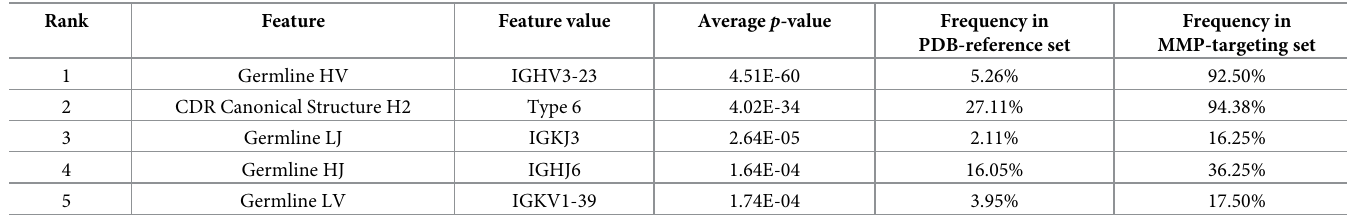
Table 3. Top 5 salient feature values as determined by Fisher Exact